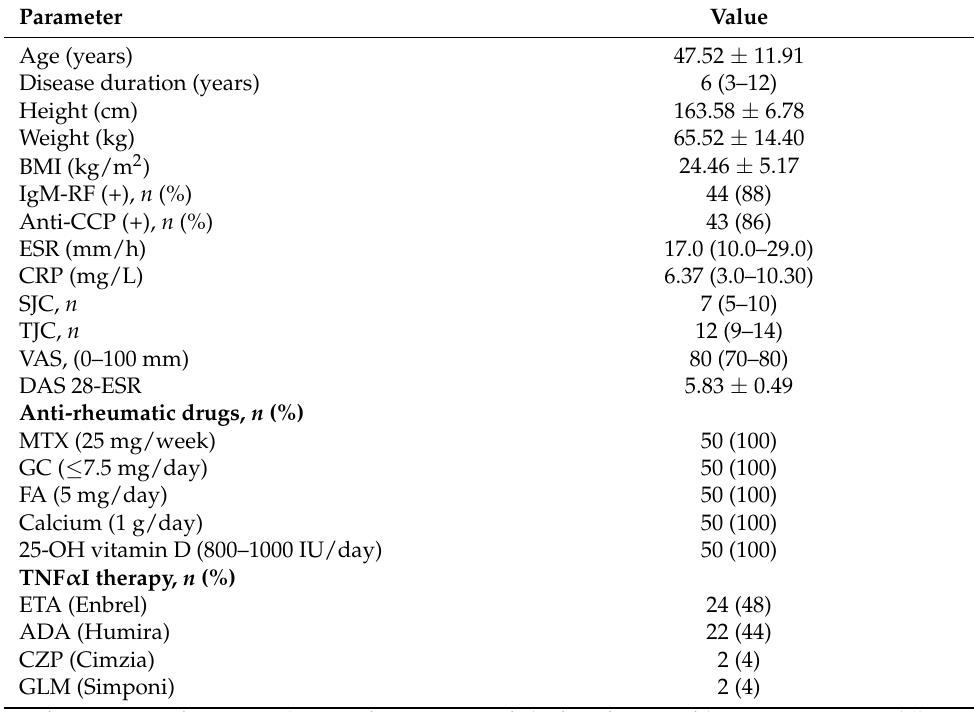
Table 1. Demographic and clinical characteristics at baseline of the 50 rheumatoid arthritis patients qualified for the treatment with TNF- α